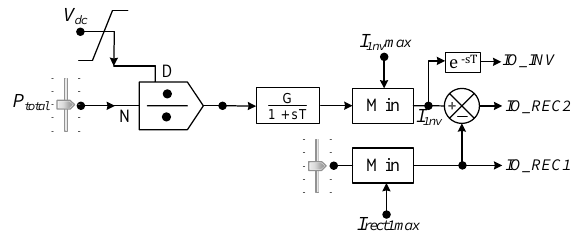
Figure 9. Overall power controller.